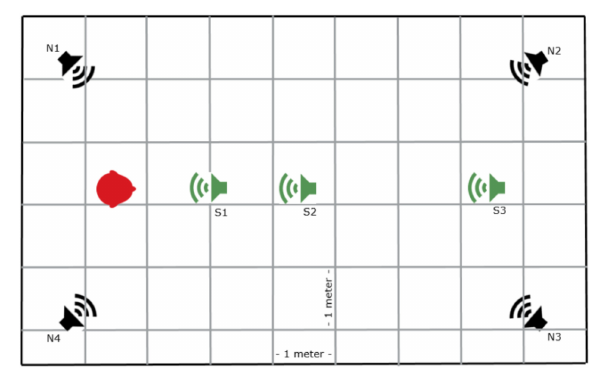
FIGURE 2 | Five speaker set up in the testing room. Four speakers playing the noise placed in the four corners (N1–N4) of the test room, and 0.75 m from the wall corner. The speaker playing speech signals were located at S1, S2, and S3, respectively. S0 is the location of the subject (Red